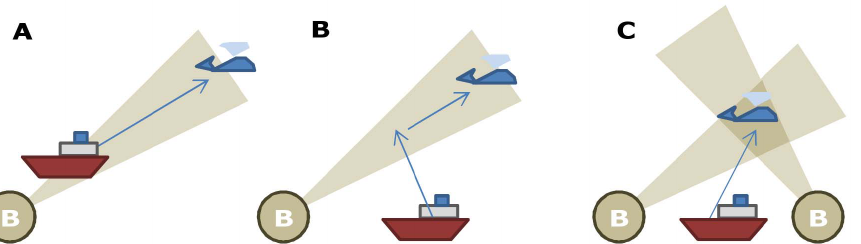
Figure 3. Model for vessel movement given a bearing to a group. Given a bearing there are three vessel actions: (A) if only a single sonobuoy is providing a bearing, and the vessel is close to the buoy-whale bearing line, the vessel follows the bearing; (B) if the vessel is too far from the bearing line, the vessel moves toward the buoy-whale bearing line; (C) If multiple sonobuoys provide bearings, a cross-bearing is calculated and the vessel goes into ‘Direct track mode’ heading straight to the position where the bearings cross (See Table S1).